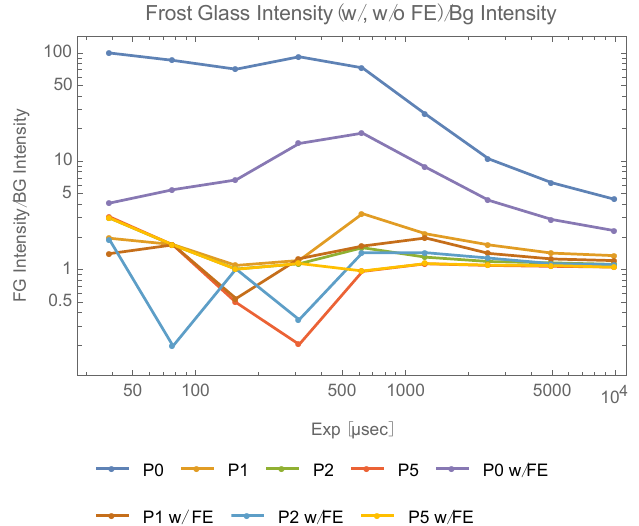
Figure A5. Frost glass intensity/background intensity.